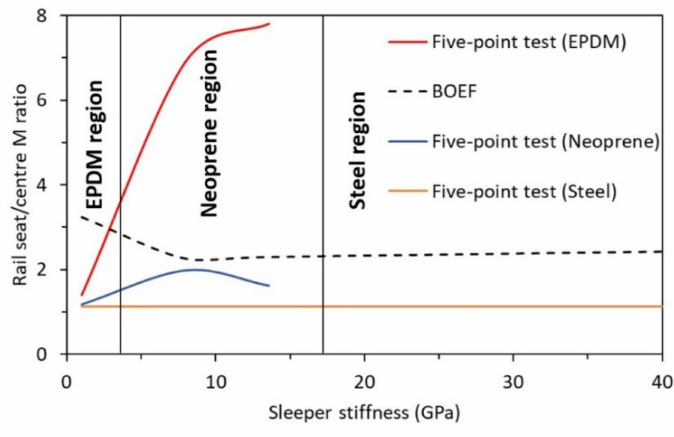
Figure 11. Relationship of positive/negative moment ratio with sleeper